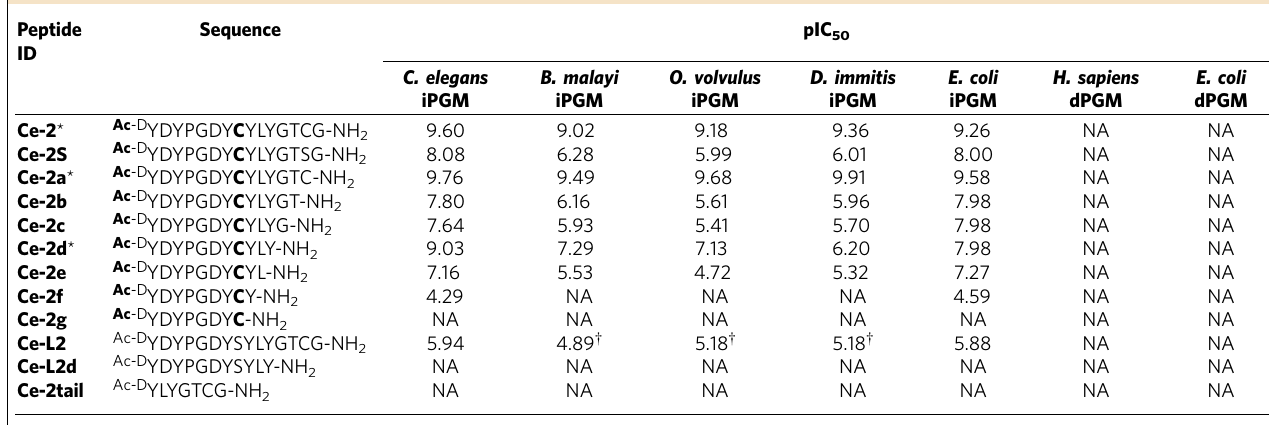
Table 2 | Inhibitory properties of ipglycermide B (Ce-2) analogues. Peptide ID